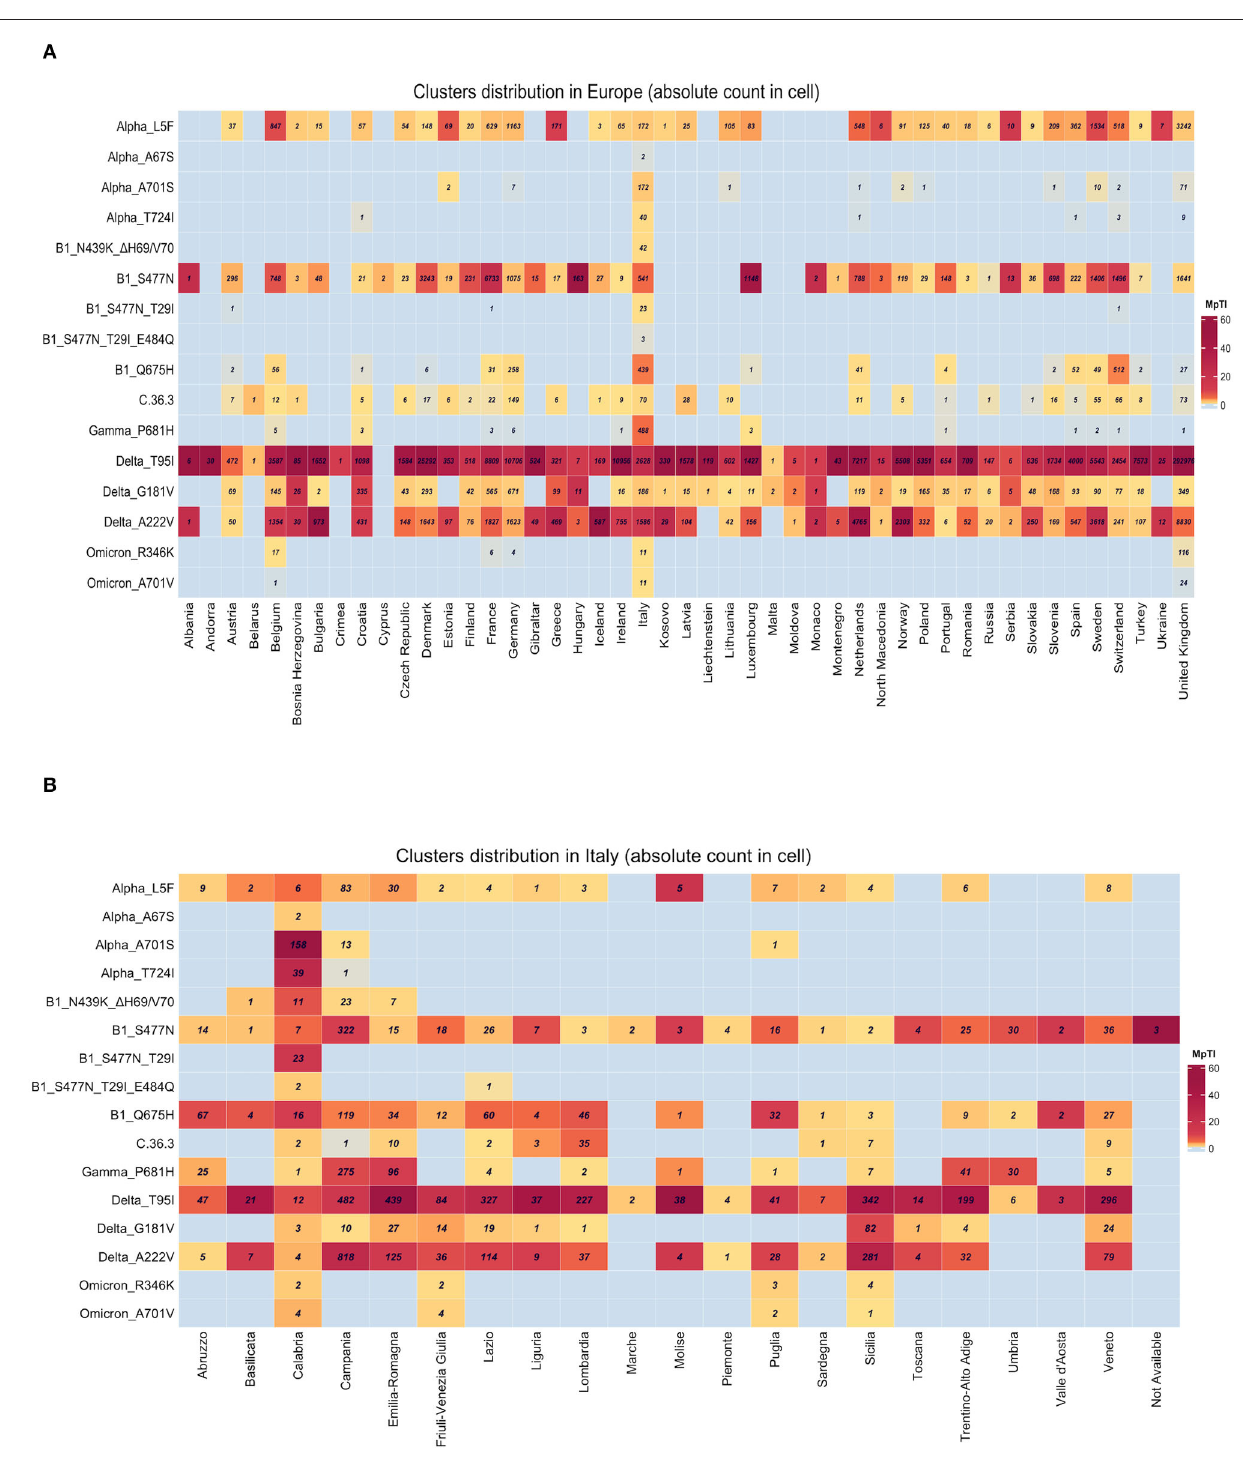
Frontiers in Microbiology |